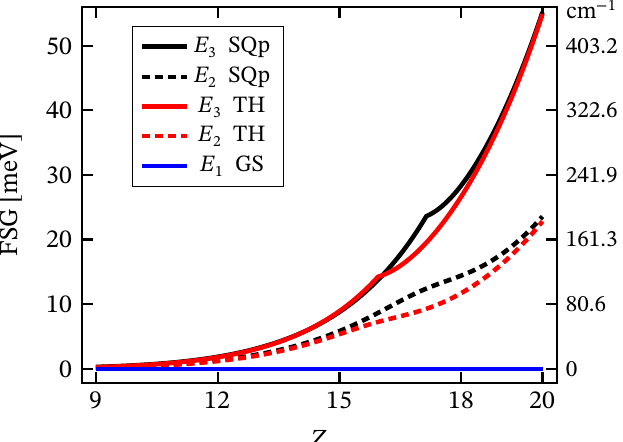
Figure 7. Zero-field FSG of the square planar (SQp) and tetrahedral (TH) geometries as a function of the metal ion’s charge number Z . Here, the abbreviation GS stands for ground state. The values of all relevant model parameters are given at the end of Section 2.1. More details about the values of first two excited energy levels in the case Z = 12 are depicted in Figure 6b. Table 1. The zero-field FSG, magnitude of the spin µ 1, s and orbital µ 1, l magnetic moments at